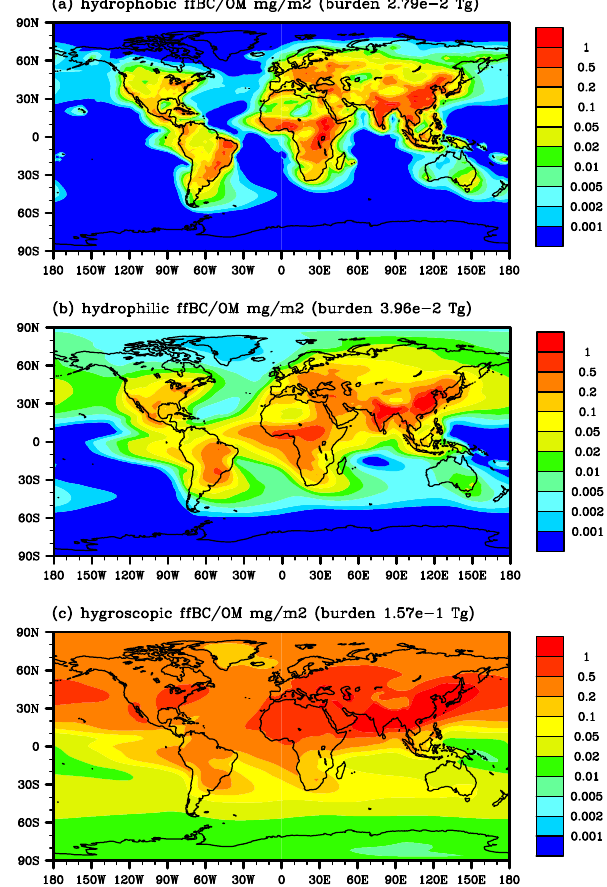
Fig. 3. PD annual average horizontal distribution of column- integrated hydrophobic (a) , hydrophilic (b) , and hygroscopic (c) ffBC/OM (mgm − 2